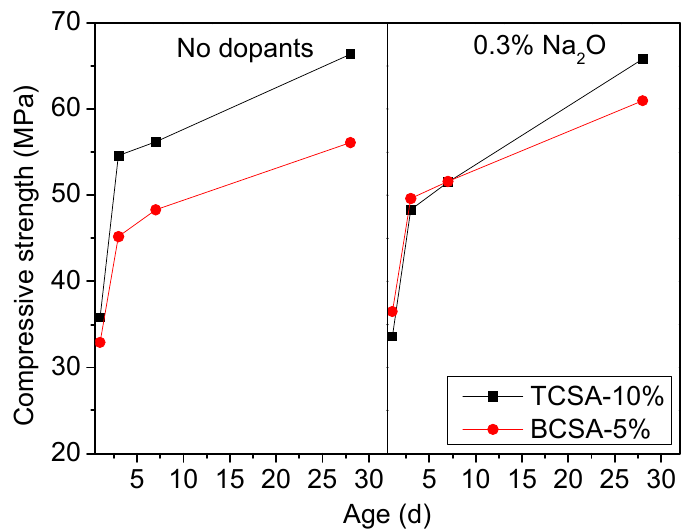
Figure 10. Compressive strengths of TCSA and BCSA cements.